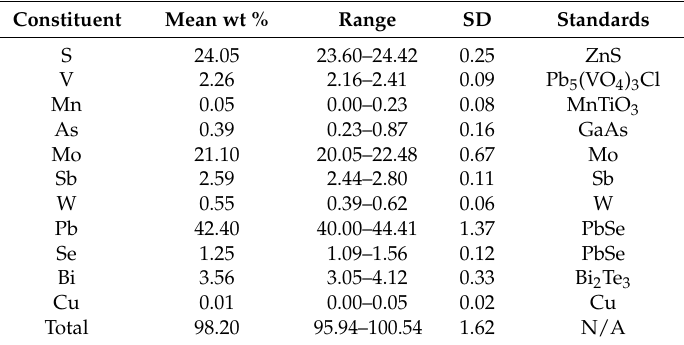
Table 2. Chemical data (wt %) for